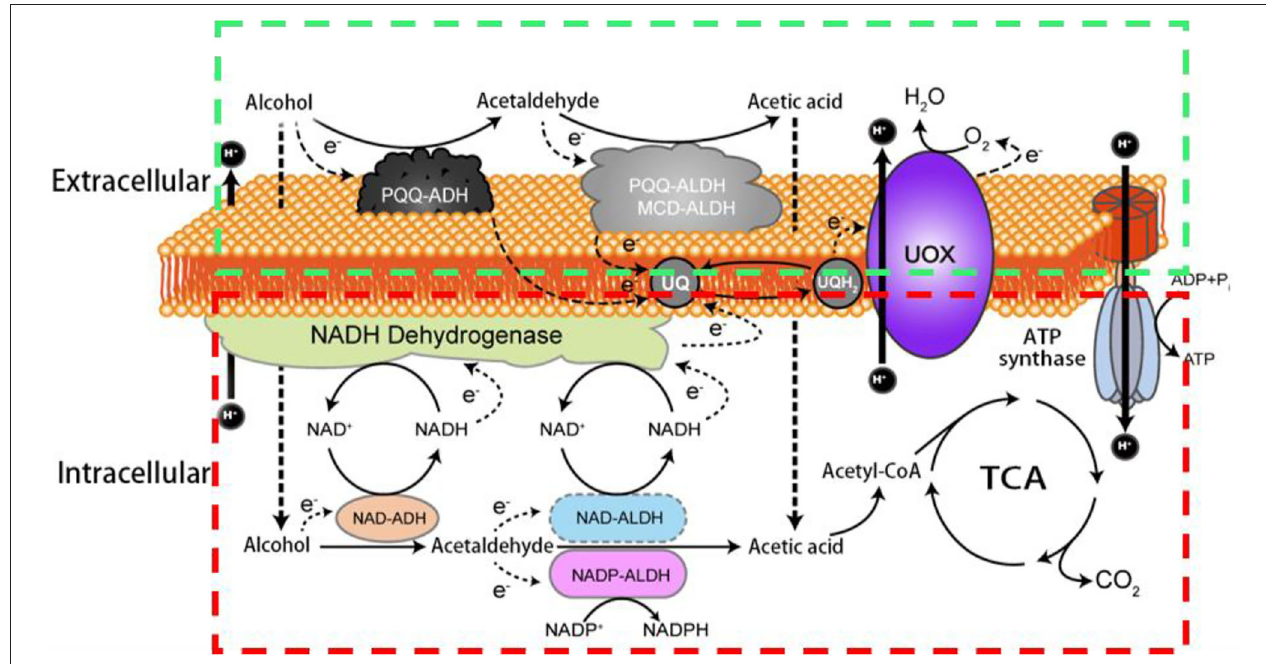
FIGURE 1 | Schematic diagram of two respiratory chains of alcohol in acetic acid bacteria. PQQ-ADH: pyrroloquinoline quinone dependent alcohol dehydrogenase; PQQ-ALDH: pyrroloquinoline quinone dependent acetaldehyde dehydrogenase; MCD-ALDH: molybdenum-molybdopterin cytosine dinucleotide dependent acetaldehyde dehydrogenase; NAD-ADH: nicotinamide adenine dinucleotide dependent alcohol dehydrogenase; NAD- ALDH: nicotinamide adenine dinucleotide dependent acetaldehyde dehydrogenase; NADP-ALDH: nicotinamide adenine dinucleotide phosphate dependent acetaldehyde dehydrogenase; UQ: ubiquinone; UQH2: ubiquinol; UOX: ubiquinol oxidase; ATP: the energy; TCA: tricarboxylic acid cycle; The green box shows the AOF respiratory chain including PQQ-ADH, PQQ- ALDH (MCD-ALDH), UQ, UQH2; UOX and ATP synthase; the red box indicates the common respiratory chain including NAD-ADH, NAD-ALDH (NADP-ALDH), UQ, UQH2; UOX and ATP